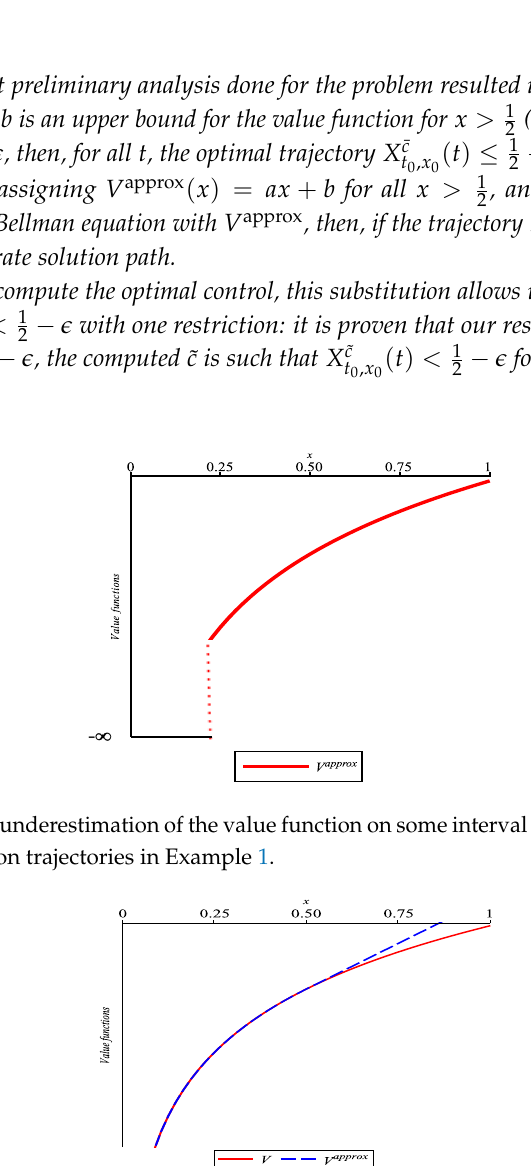
Figure 8. Intentional overestimation of the value function on some interval not influencing the optimal state and consumption trajectories in Example